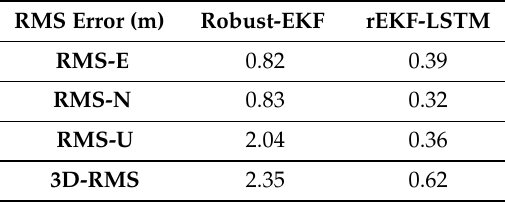
Figure 13. Comparison of position errors between robust-EKF and rEKF-LSTM. Table 3. RMS Errors in position for the two methods using data from ABMF station in late 12h.